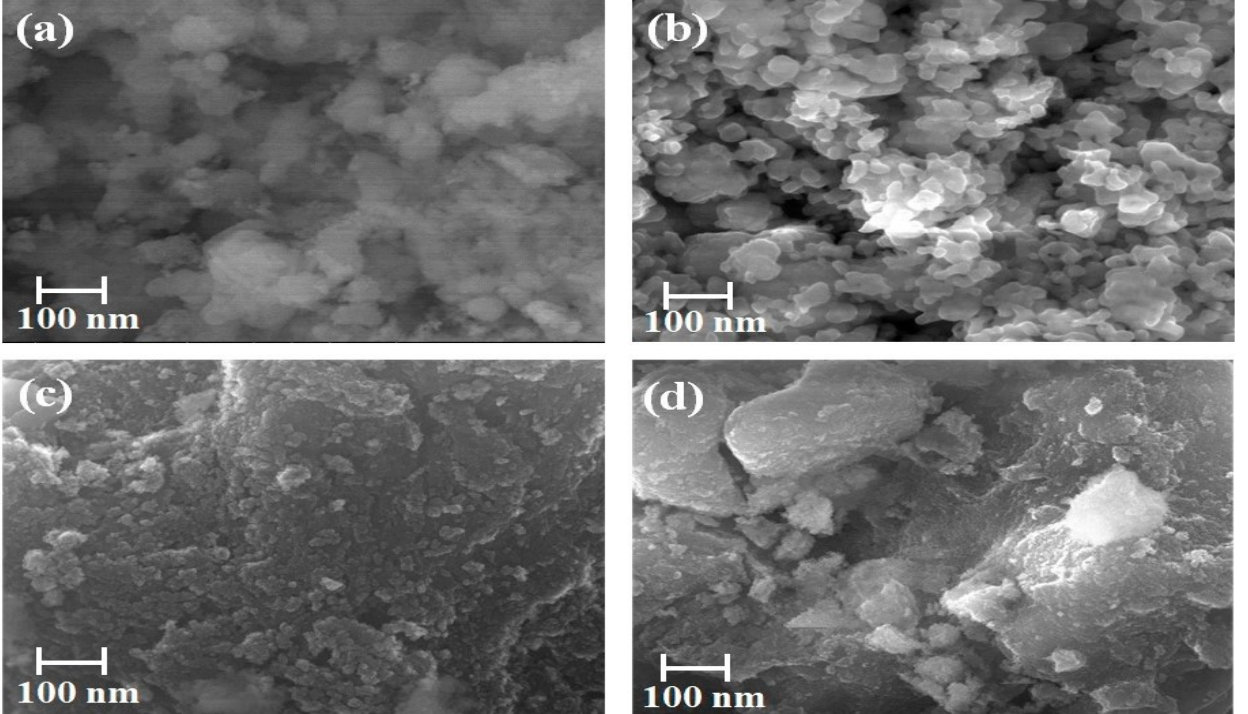
Figure 7. SEM images of ( a ) Cu/COK12, ( b ) Cu-Nb2O5, ( c ) Cu-Y-Zeolite, ( d ) Cu-ZSM5 catalyst .